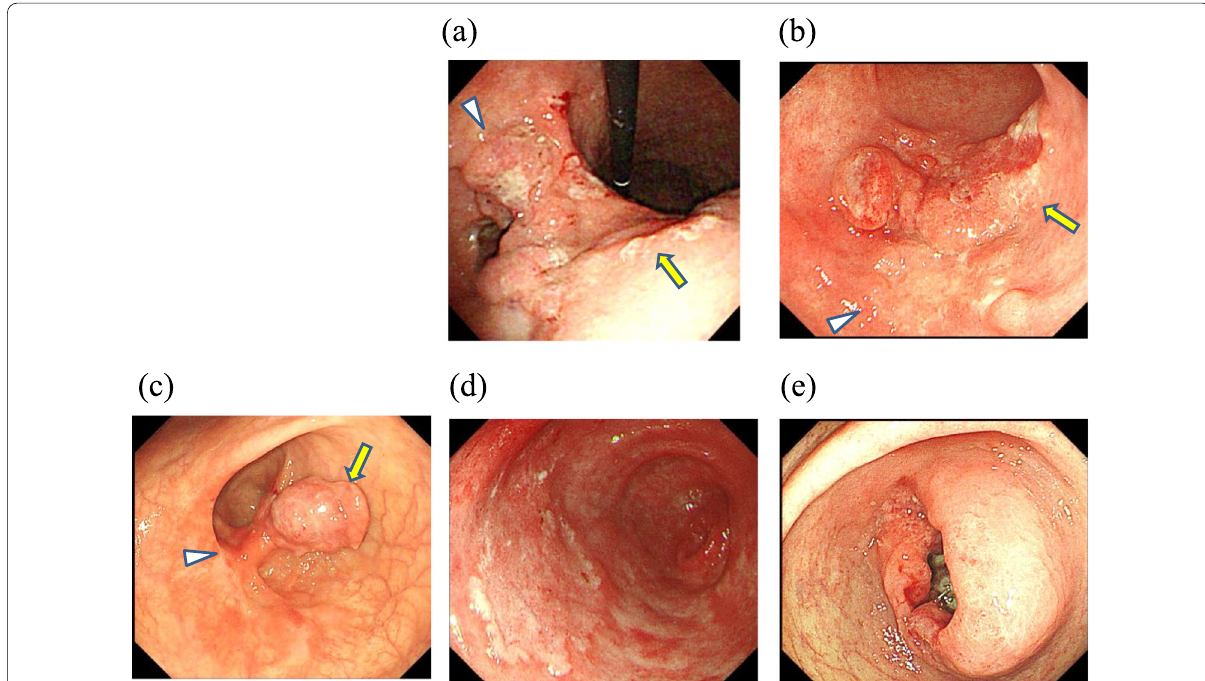
Fig. 1 Endoscopic findings of five patients with collision gastric adenocarcinoma. a Case 1: a 66‑year‑old woman; two irregular ulcers with a marginal protrusion in the gastric angle (arrow, arrowhead). b Case 2: a 66‑year‑old woman; an irregular depressed lesion (arrowhead) and a distal adjacent, depressed lesion with marginal protrusion (arrow) of the gastric antrum. c Case 3: a 78‑year‑old man; a nodular elevated lesion (arrow) associated with a reddish depressed lesion (arrowhead) in the posterior wall of the gastric angle. d Case 4: an 81‑year‑old man; an irregular slight depressed lesion in the anterior wall of the gastric angle. e Case 5: a 75‑year‑old man; an elevated lesion with an irregular ulcer in the posterior wall of the gastric